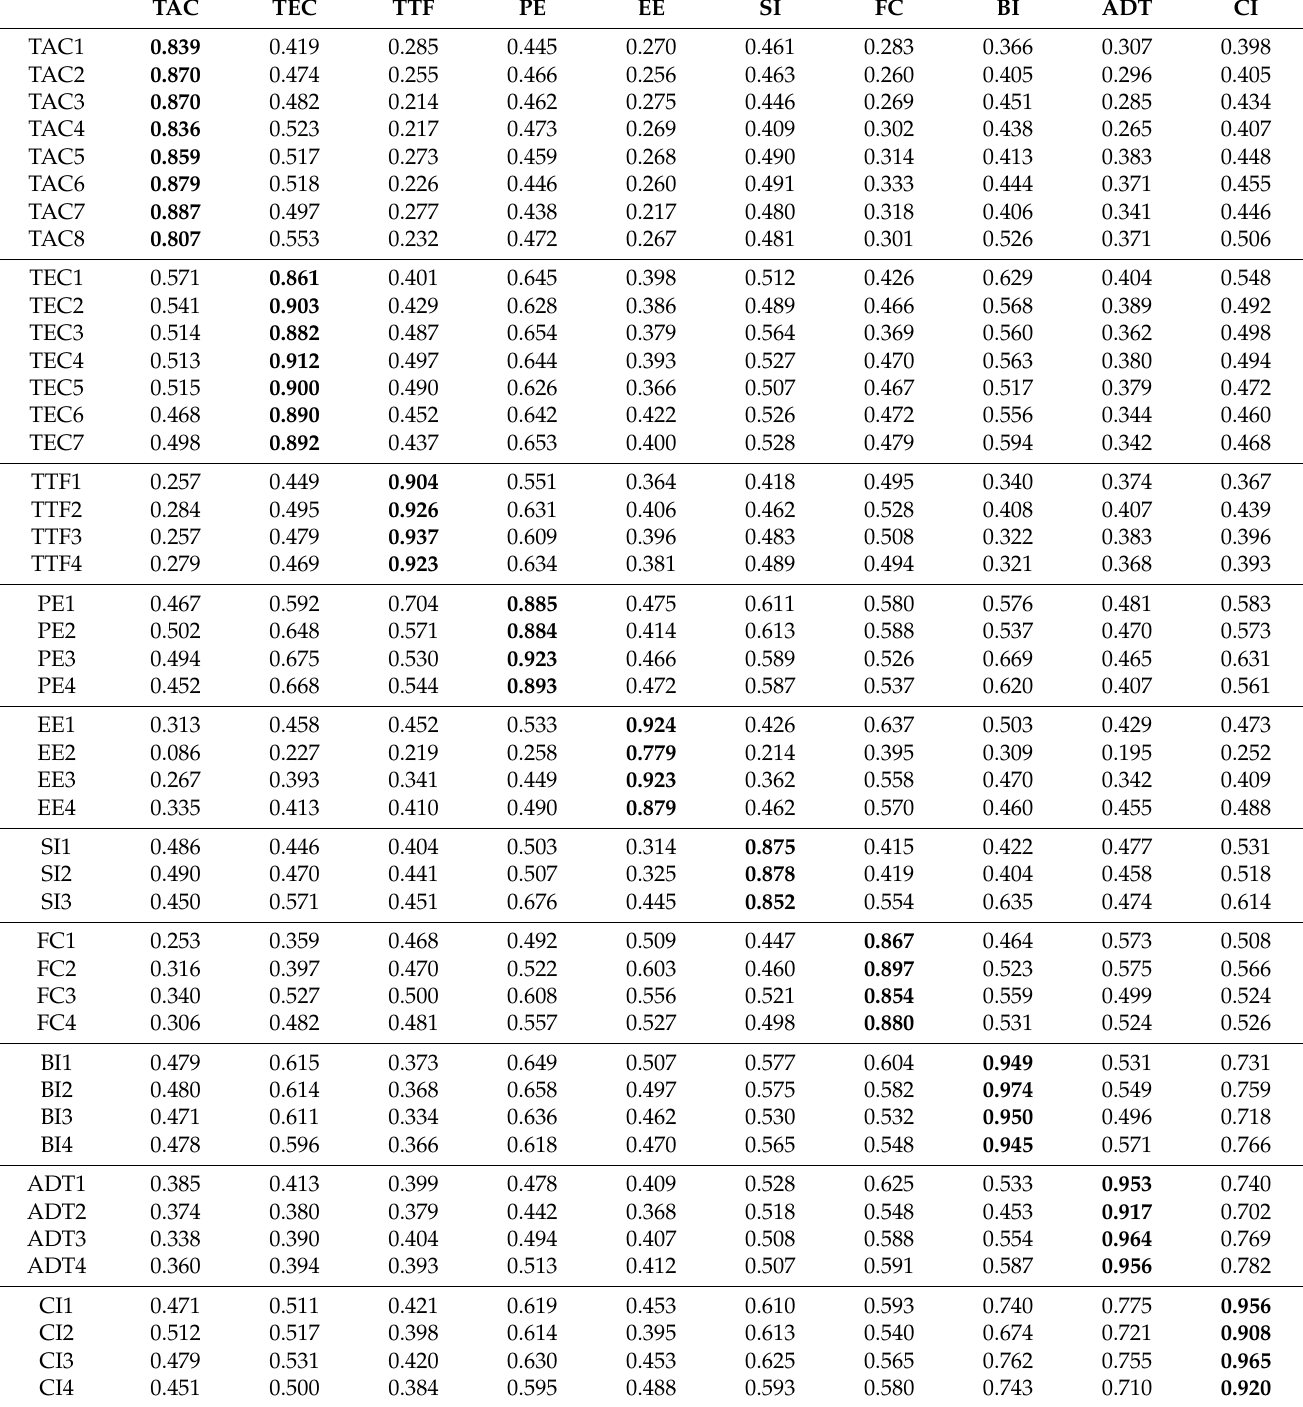
Table A2. Outer loadings and cross-loadings for the measurement